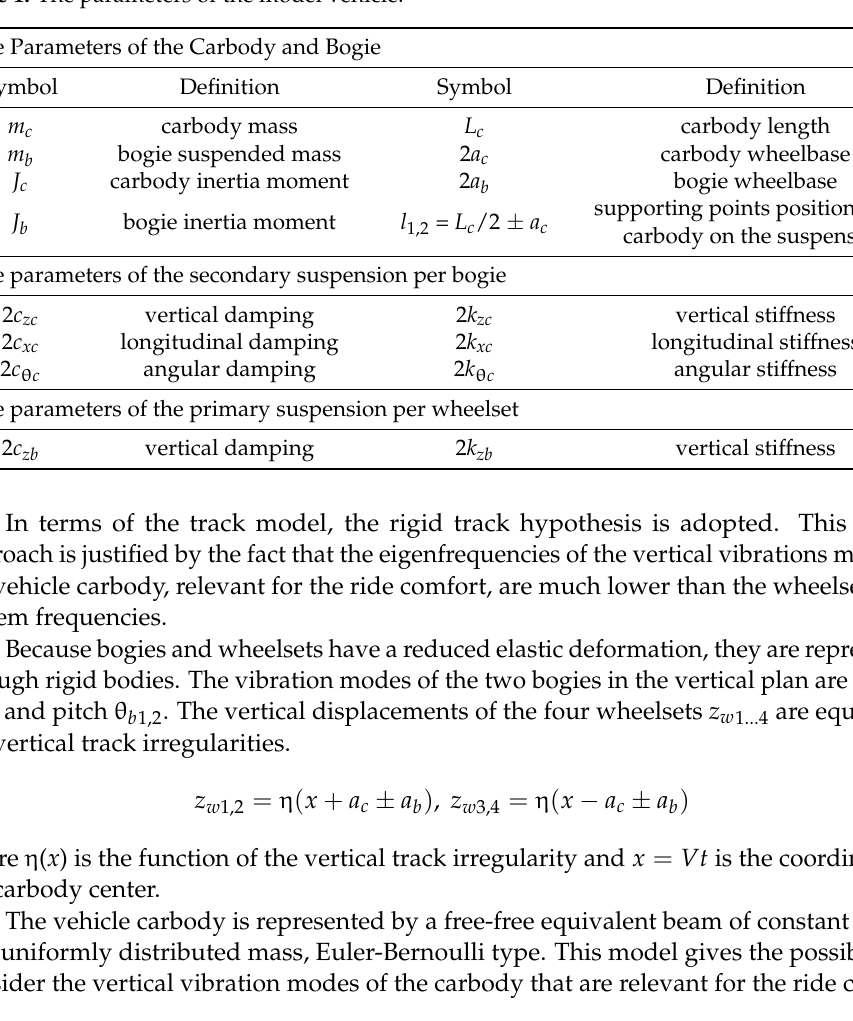
Figure 1. The mechanical model of the railway vehicle. Table 1. The parameters of the model